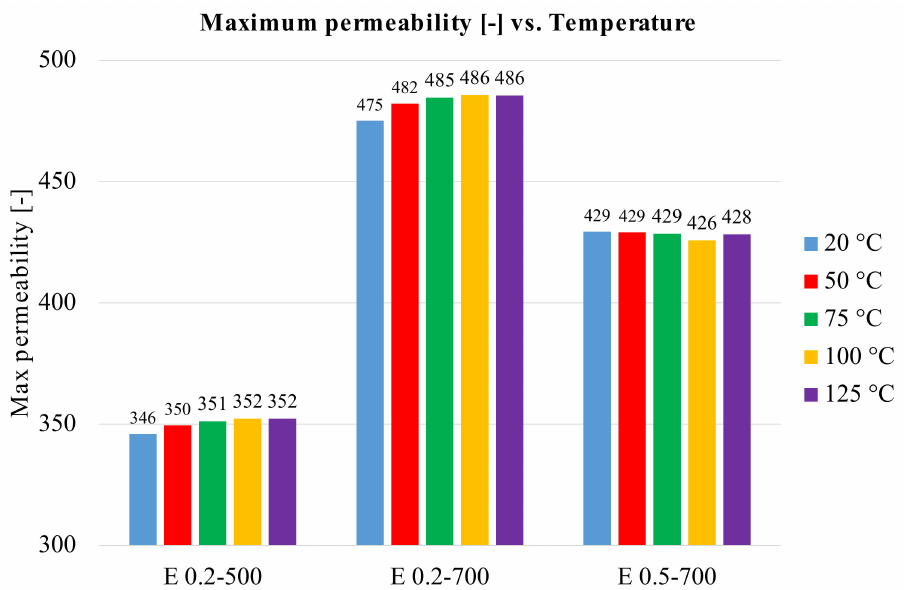
Figure 10. Maximum magnetic permeability of SMC samples for different temperatures.